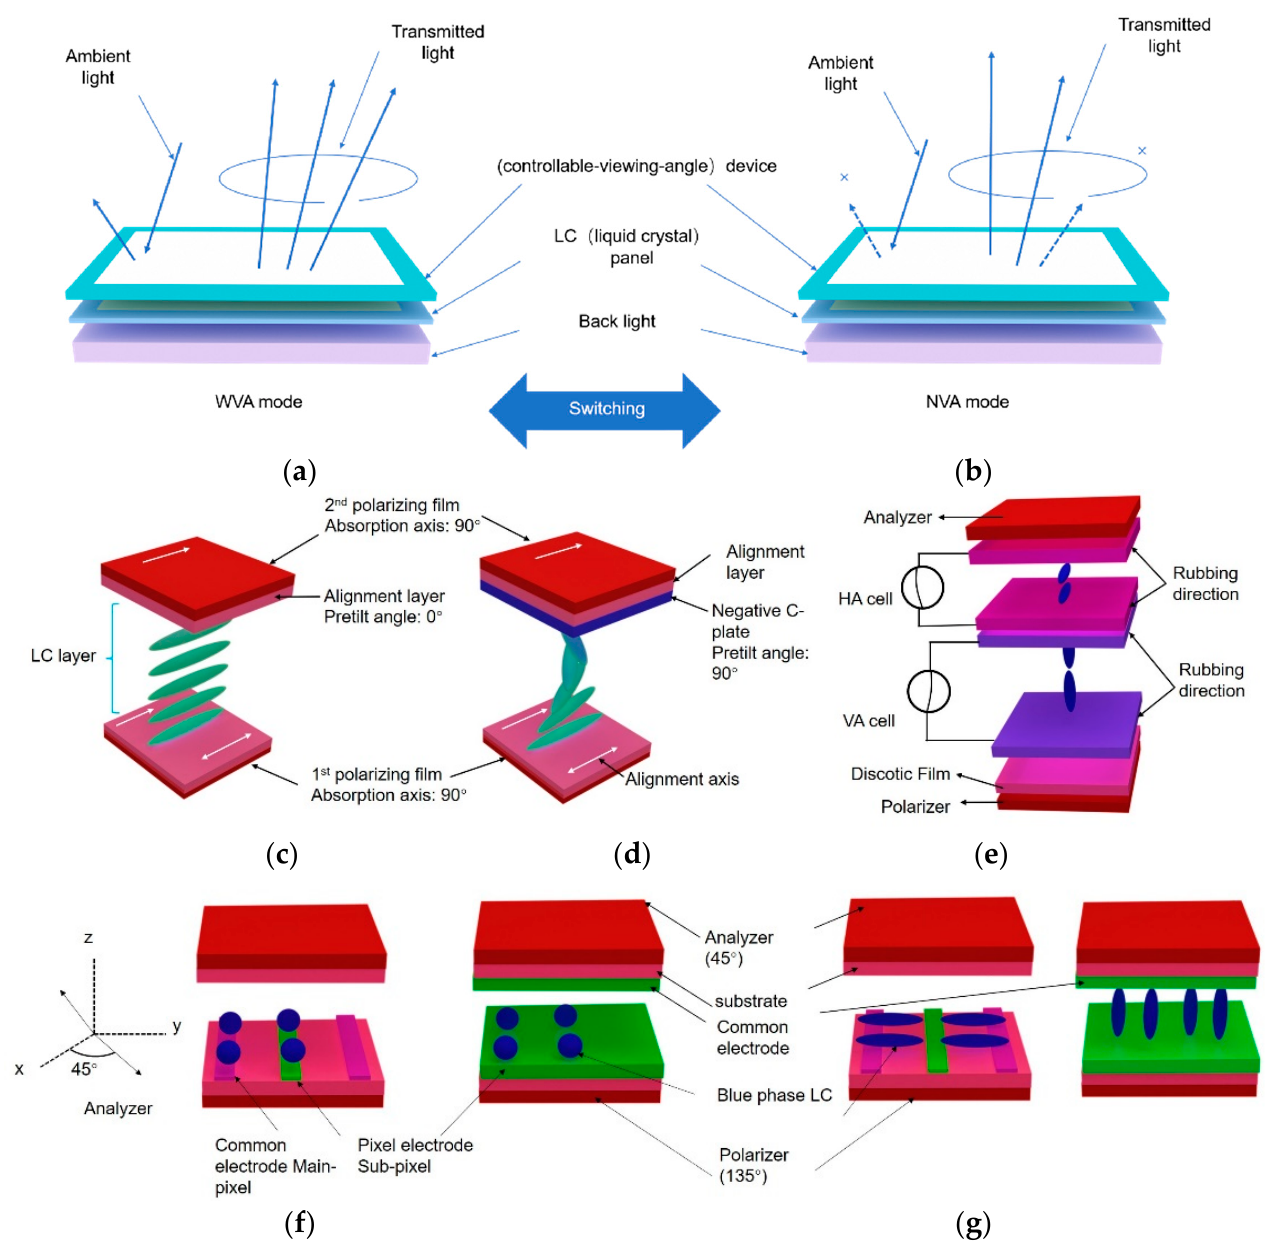
Figure 2. Schematic diagram of controllable viewing angle LCD: ( a ) WVA mode; ( b ) NVA mode. Schematic diagram of simulation models of controllable viewing angle device: ( c ) homogeneous aligned LC cell and ( d ) HAN LC cell; ( e ) optical cell configurations of the viewing angle device; ( f ) switchable LCD with an optically isotropic LC: voltage-off state and ( g ) voltage on state. To decrease the volume, weight and fabrication cost of LCD, a viewing angle switch- able LCD owning an interlayer support with surface microstructures that is placed between the top and bottom substrates, the original LC layer is for presenting images and the complementary LC layer is for viewing angle tunning, thus WVA and NVA can be switched between ± 70 ◦ and ± 40 ◦ [19]. A viewing angle controllable LCD using two stable states of bistable nematic LC such as splay and 180 ◦ -twist at π cell with three-terminal electrodes, WVA is shown at splay state with interdigitated electrodes at the IPS or FFS modes, NVA is presented at the twisted state with vertical electrode